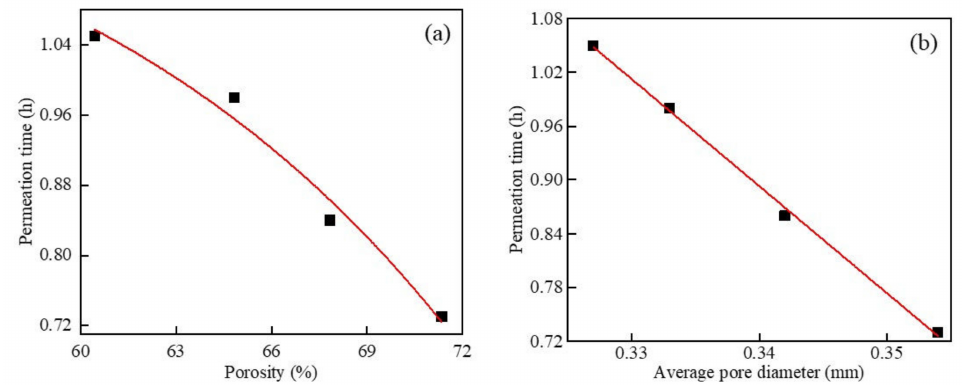
Figure 19. Impermeability versus porosity ( a ) and average pore diameter ( b ) of the recycled foamed concrete containing MSWI powder with different water–binder